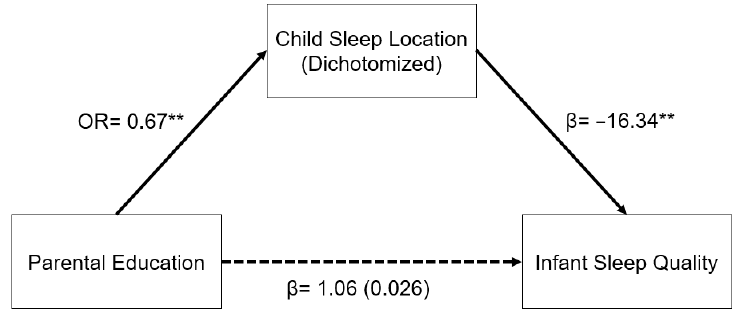
Figure 2. Regression coefficients or odds ratios for the relationship between years of parental edu- cation and infant sleep quality (mISS) as mediated by sleep location (1 = room with parents). Child sleep location is a significant indirect mediator of the link between parental education and infant sleep quality. The regression coefficient between parental education and mISS, controlling for sleep location, is in parentheses. ** p < 0.01.